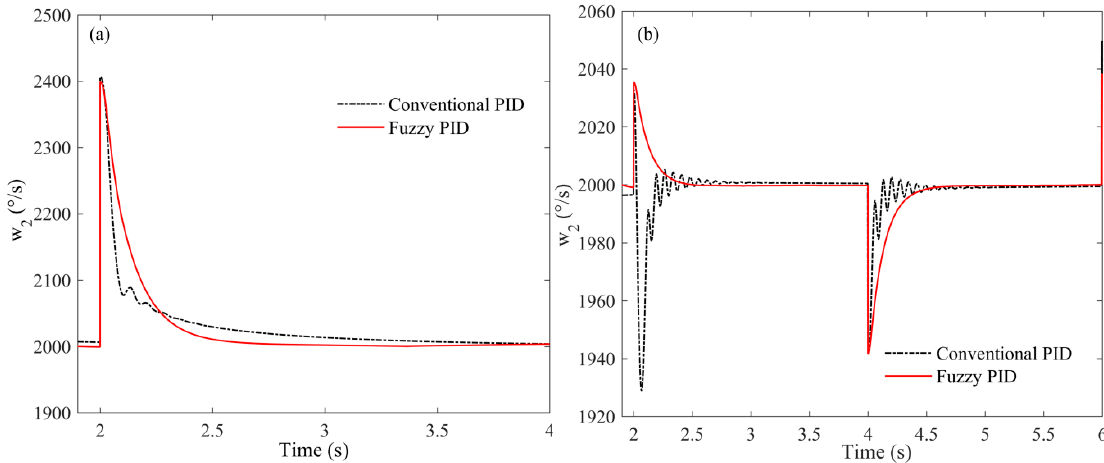
Figure 9. Comparison of the anti-interference performances of the designed fuzzy PID controller and the conventional PID controller: ( a ) step disturbance; ( b ) white Gaussian noise.